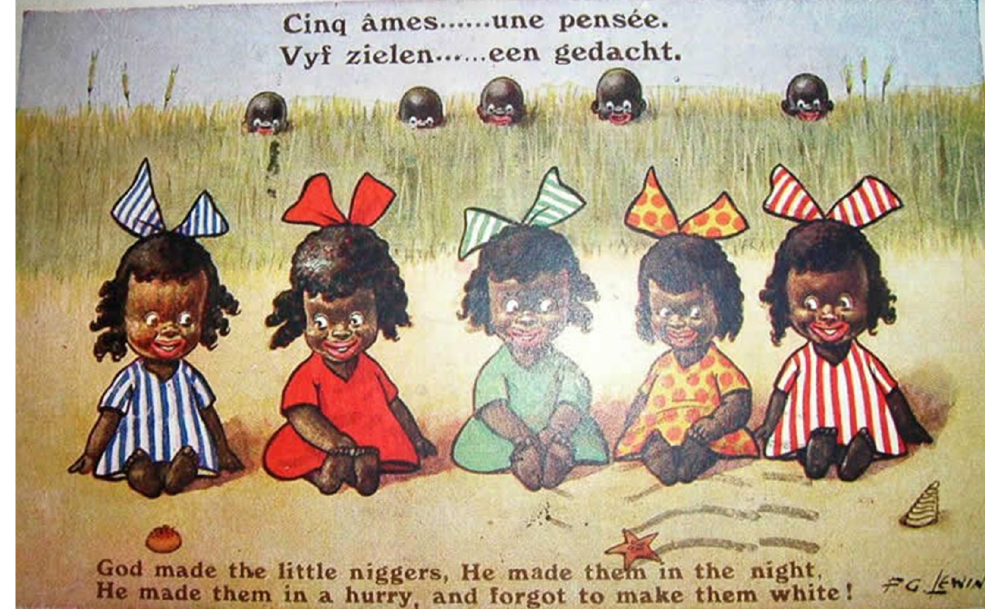
Figure 2. Caricature and familiar childhood verse (Lewin n.d.). Lynda Graham’s (1939) Pinky Marie: The Story of Her Adventure with the Seven Bluebirds mocks a Black girl child because of her hair and non-white skin color. Violence and child trauma in this children’s book take the form of birds attacking and stealing the child’s ribbons while she sleeps. As in other stories, the Black child is linked with animals meant to do her harm, this time by violating her body in its most vulnerable state, during sleep. Pinky Marie has two Black parents whose names are meant to be funny and mocking, and even nonsensical for children, because their names are too many “white names” strung together, seemingly for importance. Additionally, Pinky Marie and her parents are not just Black; they are very Black: